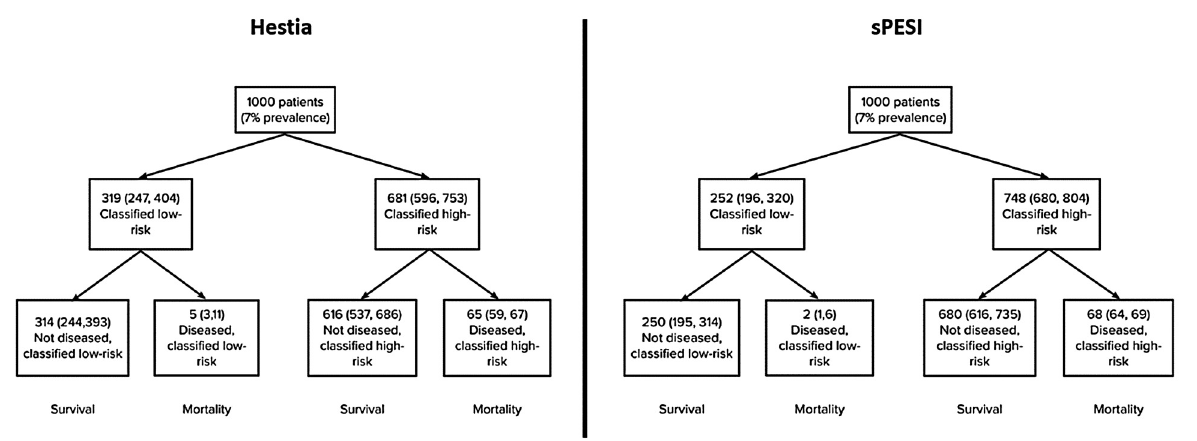
Fig. 4 show the survival outcomes for Hestia Criteria and sPESI score according to the risk-strati fi cation, assuming an average of 7% mortality. For every 1000 patients with PE, Hestia misclassi fi es 5 patients with low mortality risk, while sPESI misclassi fi es 2